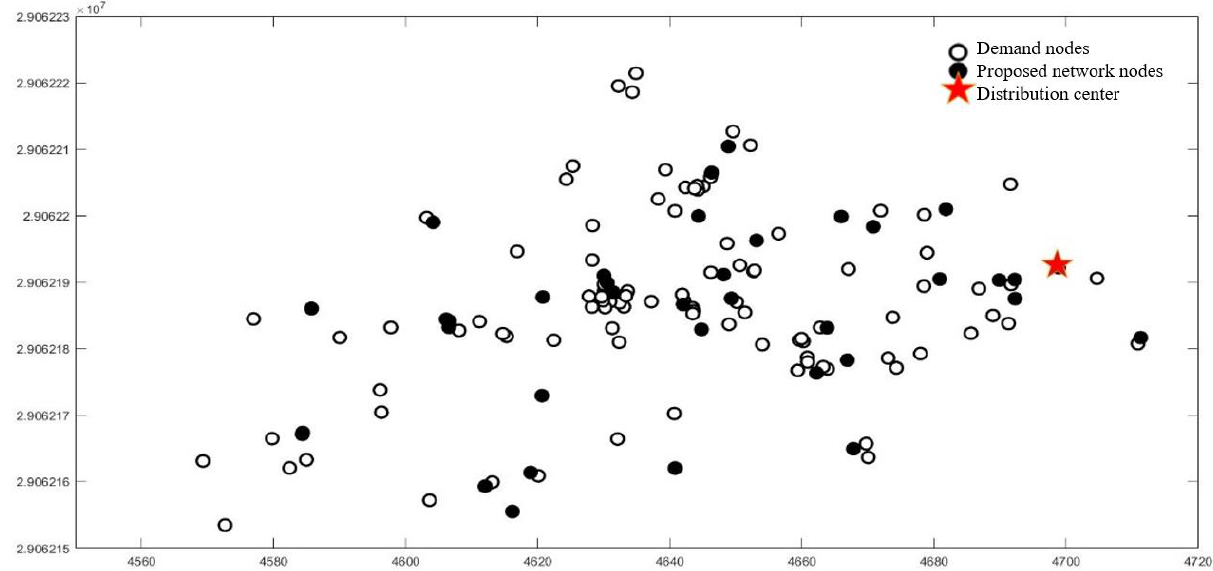
Figure 7. Optimal location scheme.